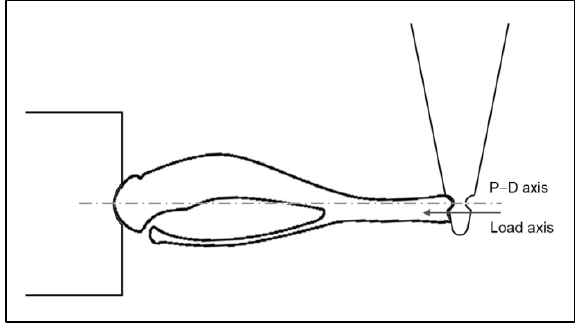
Figure 1. Scheme of the fixing method employed to uniaxially load bone specimens. P–D axis is the proximal-distal axis.